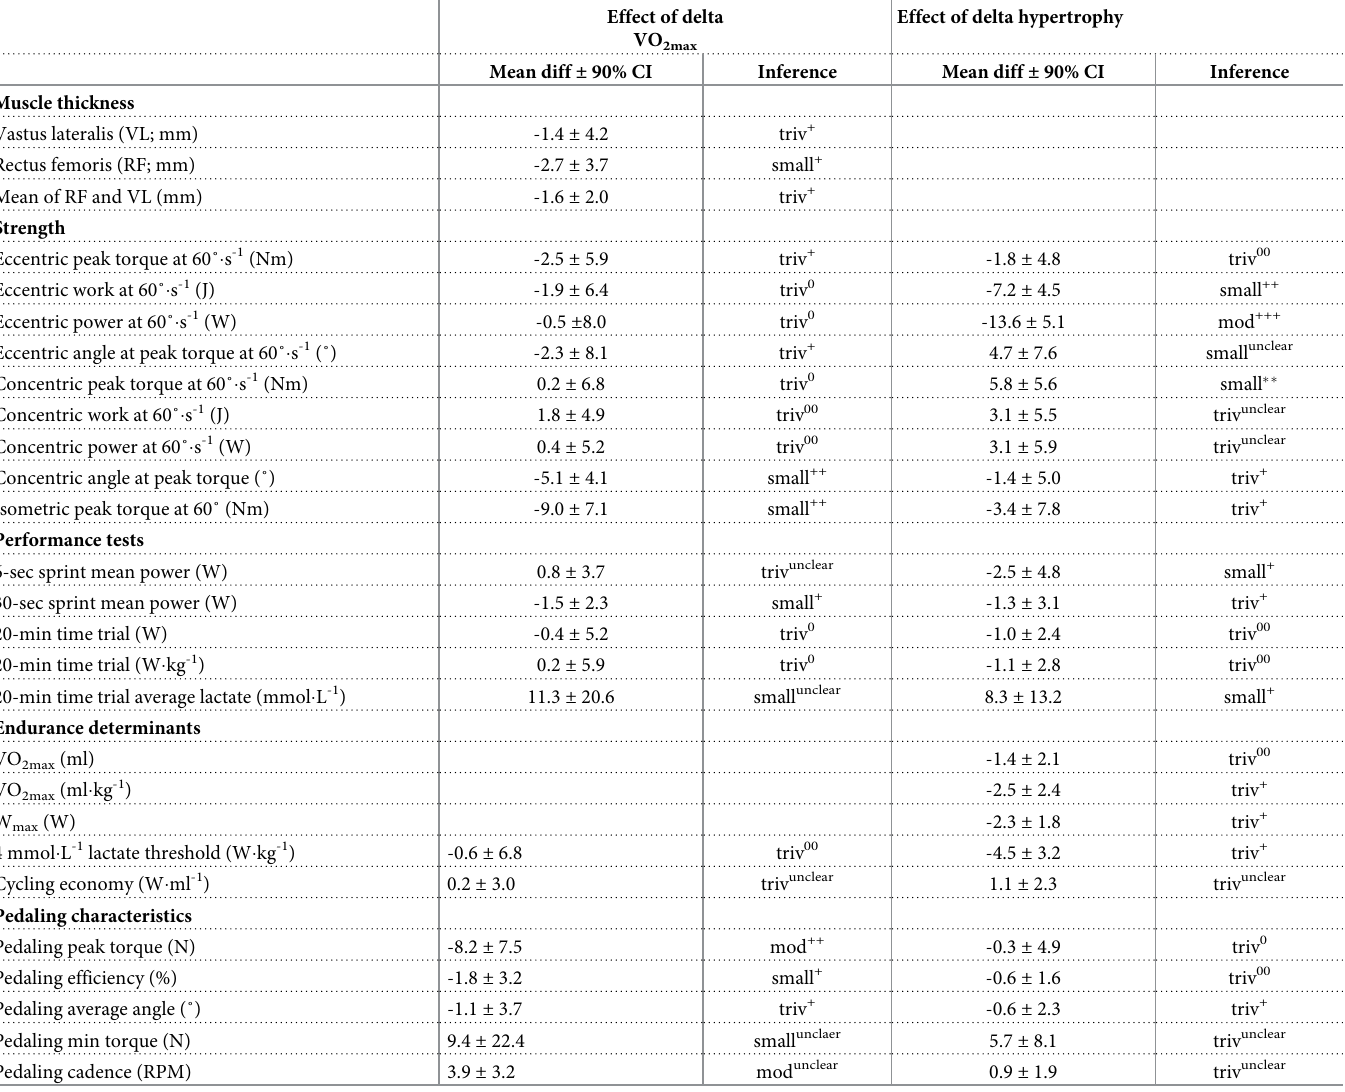
Table 4. Percent effect of change in VO 2max and change in hypertrophy (mediators) on the difference between